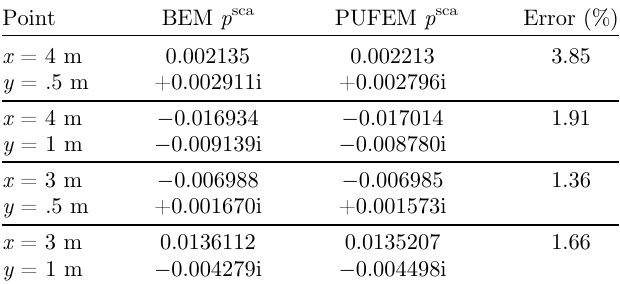
Figure 13. Pressure fi eld comparison : BEM vs. PUFEM-PML at 800 Hz. Table 1. Comparison BEM against PUFEM.